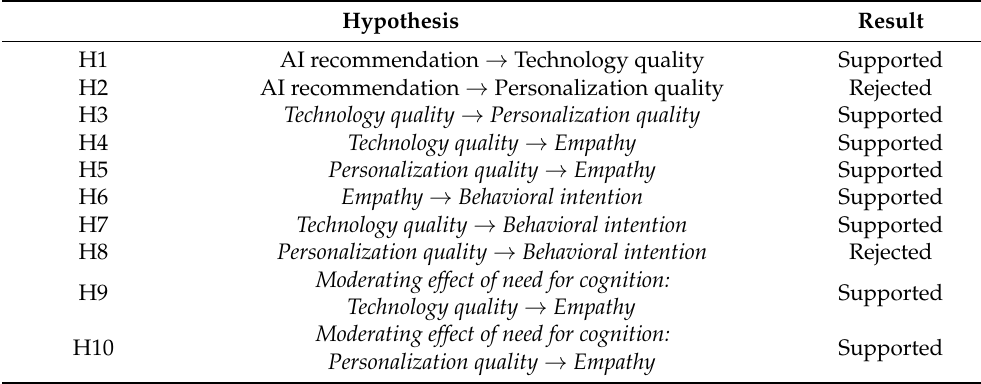
Table 5. Hypothesis